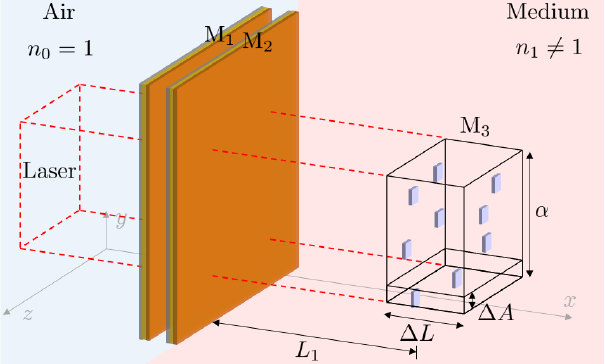
Figure 9. Schematic view of an experimental setup, which contains a Fabry-Pérot cavity as well as a group of tiny mirrors, which are randomly positioned in a medium with refractive index n (cid:54) = 1. These additional mirrors occupy a volume of length ∆ L and covering an area α , which is placed some distance L 1 away from the cavity. An incoming laser with its cross section given by α approaches the cavity and the additional mirrors from a perpendicular direction. For simplicity, we assume here that the additional mirrors only cover a relatively small percentage of the area such that each one of them is likely to be observed by the incoming laser